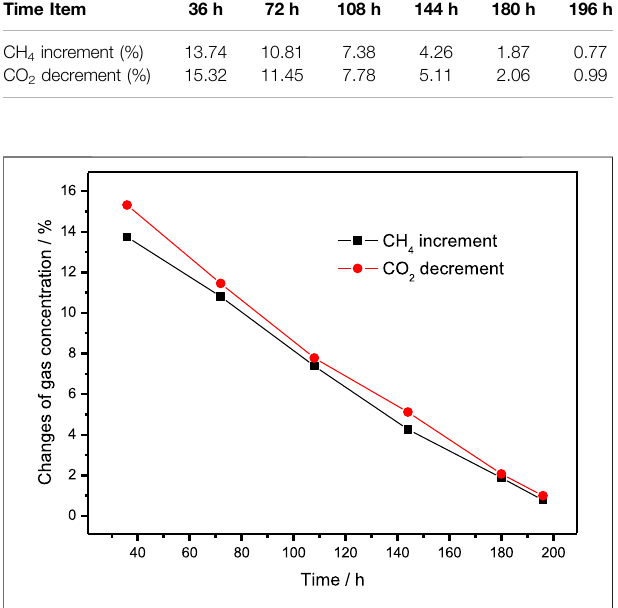
FIGURE 3 | The curve of CH 4 increment and CO 2 decrement in gas samples collected every 36 h in Experiment